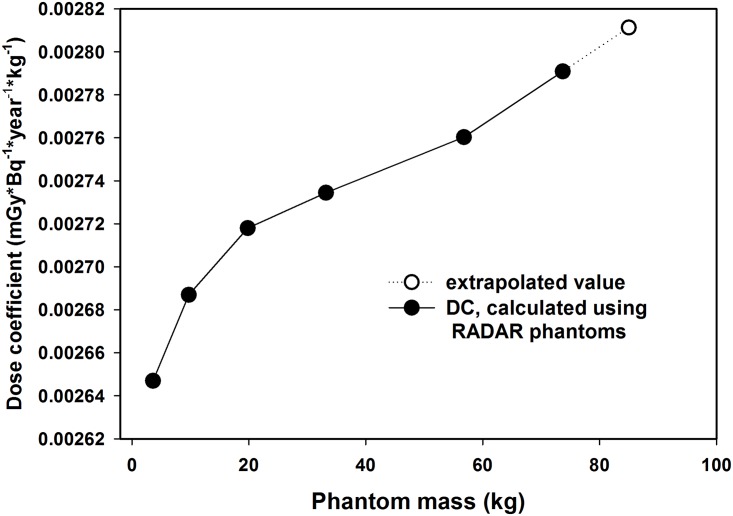
Dependence of dose coefficient on body weight.